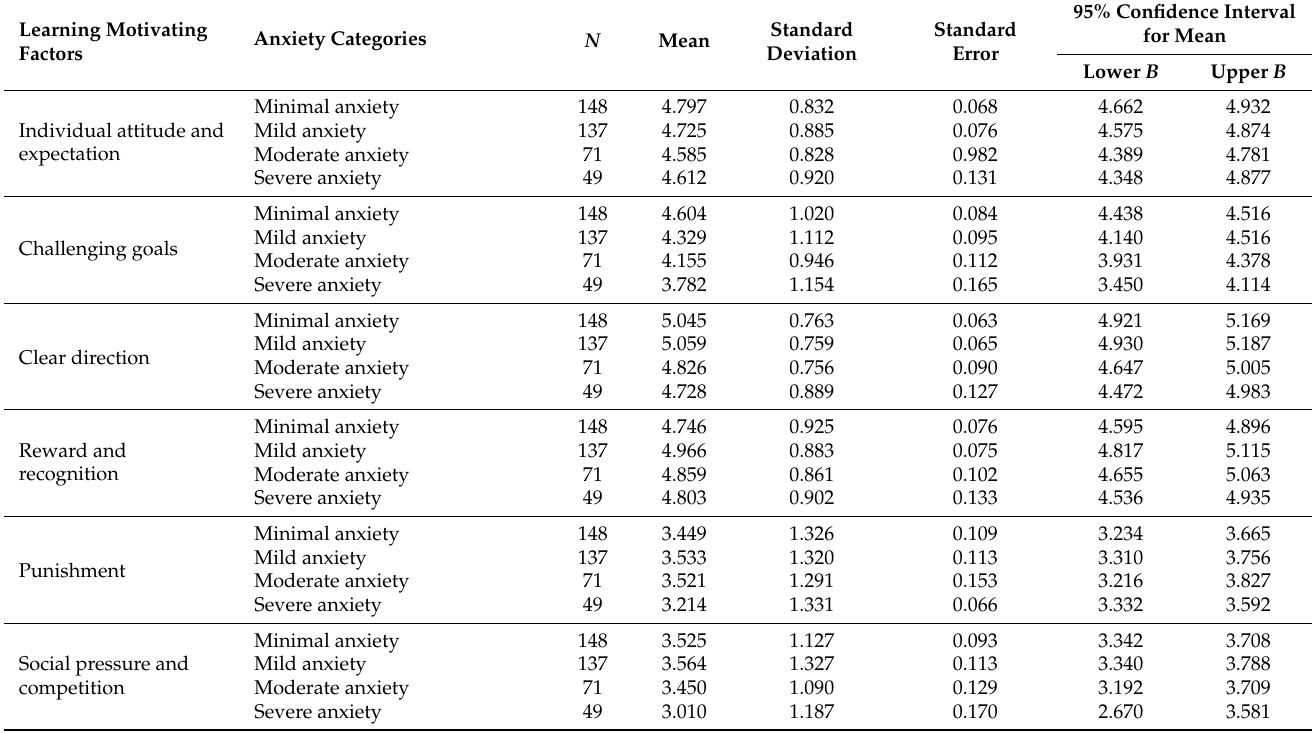
Table 9. Differences in learning motivating factors based on the GAD-7